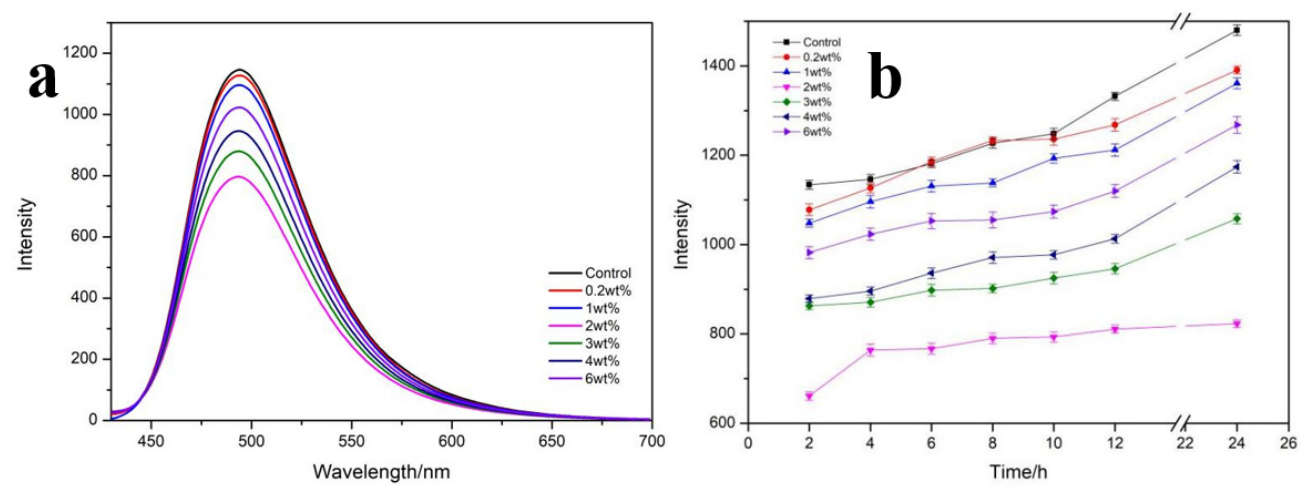
Figure 6. ( a ) The fluorescence emission spectra of RSF/MoS 2 NPs with different mass fractions at 4 h. ( b ) The fluorescence intensity of RSF/MoS 2 NPs with different mass fractions changed with time.